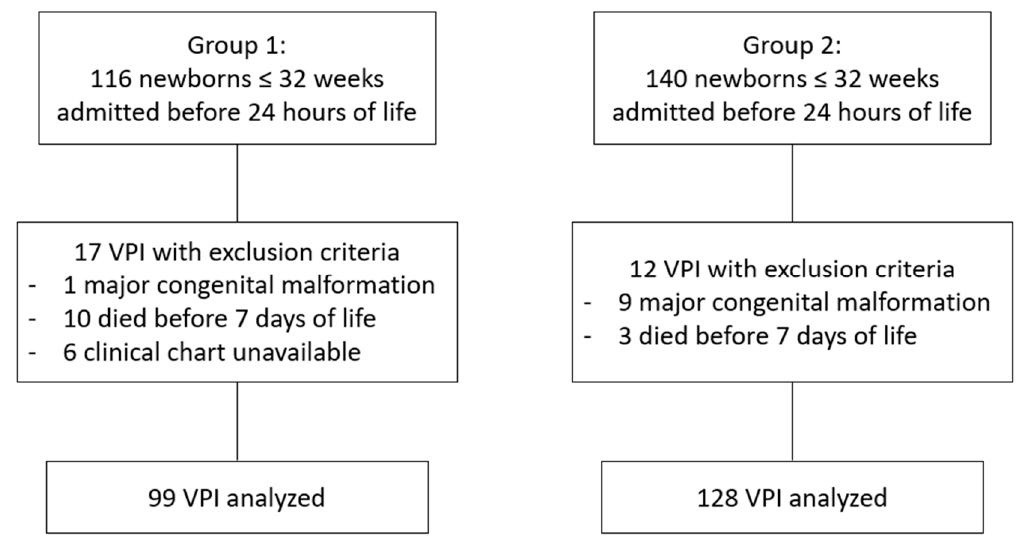
Figure 1. Flowchart of study participation.